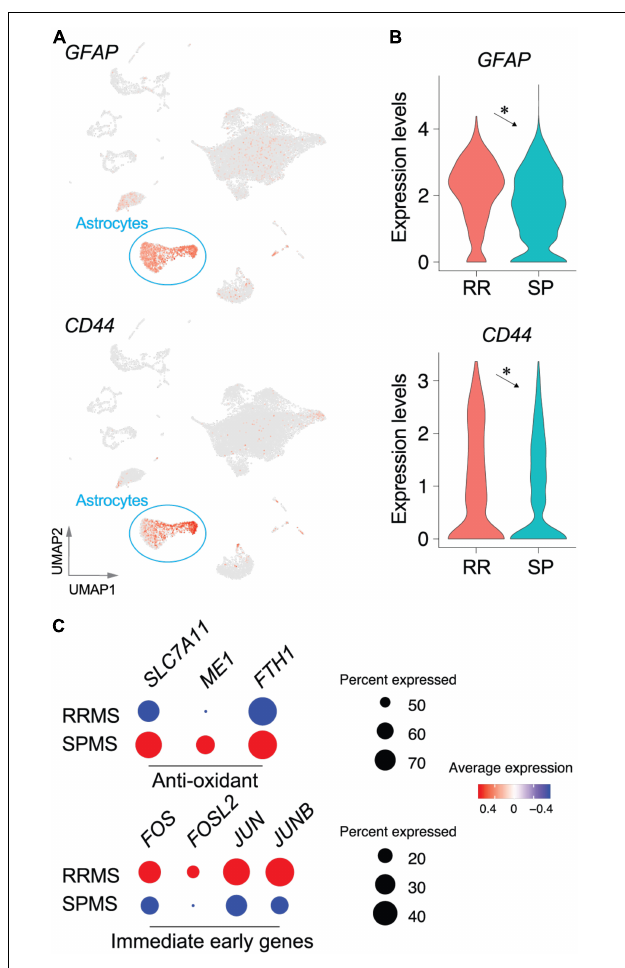
FIGURE 4 | Transcriptomic changes in astrocyte populations between RRMS vs. SPMS. UMAP (A) and violin plots (B) of astrocyte marker genes. ∗ , adjusted p -value < 0.05. (C) Dot plots of genes associated with antioxidant pathways and immediate early genes. Size and color indicate the CDRs and expression levels, respectively. Statistical results for DEGs, CDRs, and VAGs are provided in Supplementary Tables 4–6 .